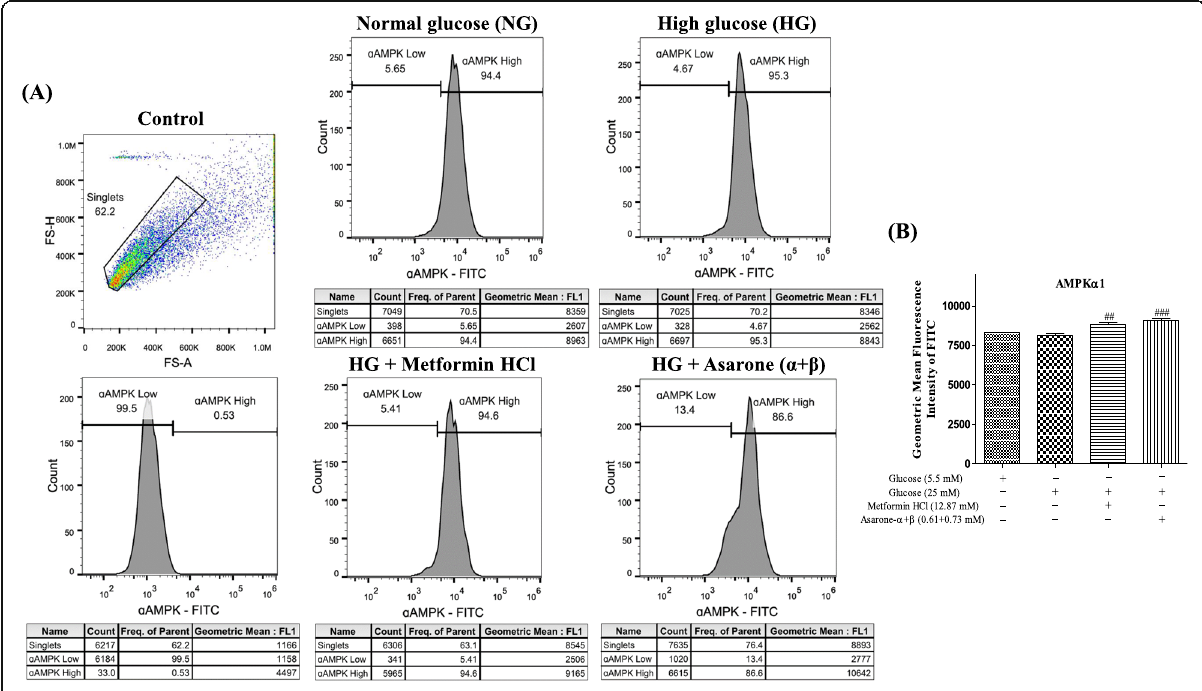
Fig. 6 The treatment of high glucose-promoted HepG2 cells with metformin and asarone upregulates the expression of AMPK α 1. a A representative flow cytometry histogram events depicting the expression of AMPK α 1 cultured in normal glucose (NG; 5.5 mM), high glucose (HG; 25 mM), HG + Metformin HCl, and HG + Asarone. b Bar diagrams represent geometric mean fluorescence intensity (GMFI) of AMPK α 1 in HepG2 cells. Values represent mean ± SEM of an experiment done in triplicate; one-way ANOVA followed by Bonferroni test, where ## p < 0.01 and ### p < 0.001 compared to the high glucose (HG)